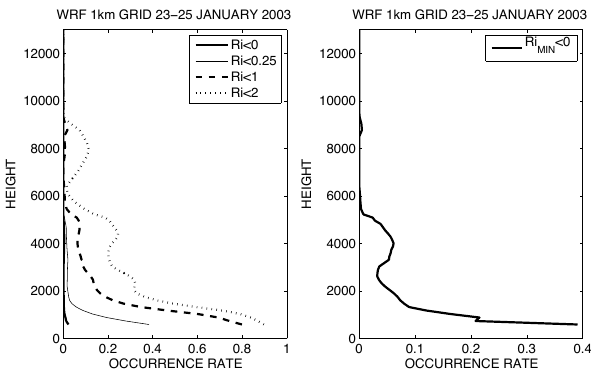
Fig. 15. Left-hand side : occurrence rates for low values of Richard- son number for the whole of the innermost model domain, and for the period from 00:00UTC on 23 January to 24:00UTC on 25 Jan- uary 2003. Right-hand side: the average (over latitude and time) of the occurrence rate of convective instability at any location along a latitude circle, within the innermost model domain. This represents the chance that an air-mass crossing the domain will encounter a region of convective instability somewhere along its path from west to